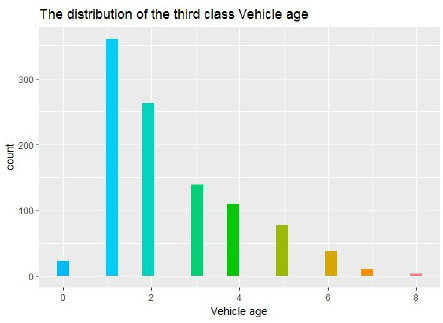
Figure 4. Distribution of auto age.